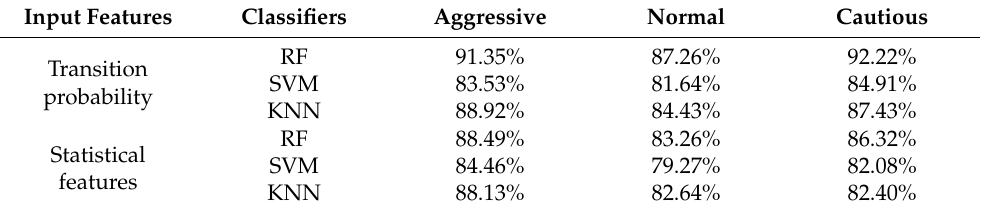
Table 5. Classification accuracy of the three classification algorithms under different feature